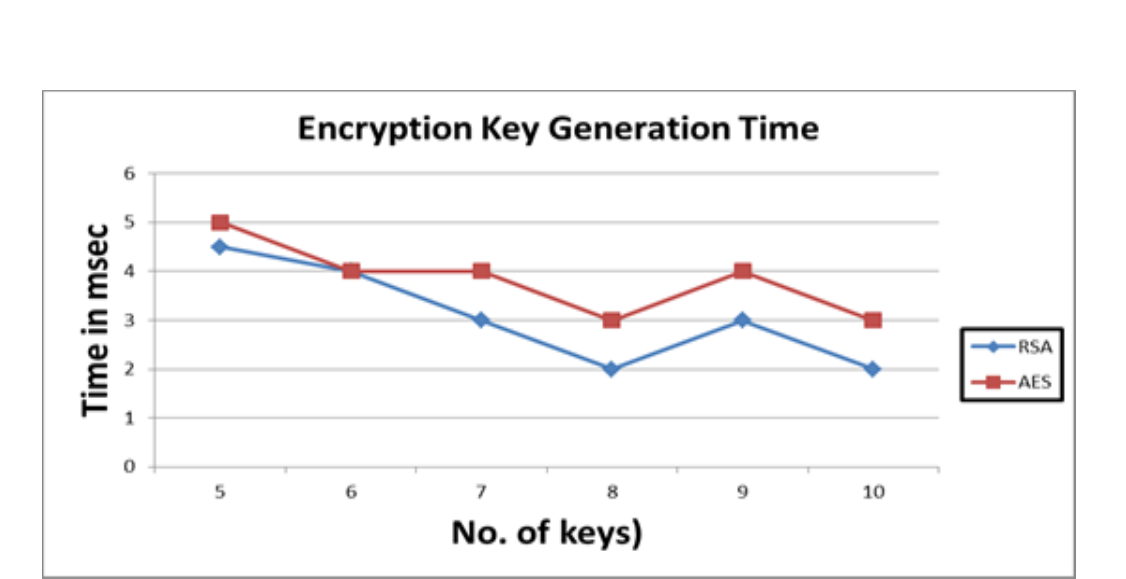
Figure 9 . Encryption Key Generation